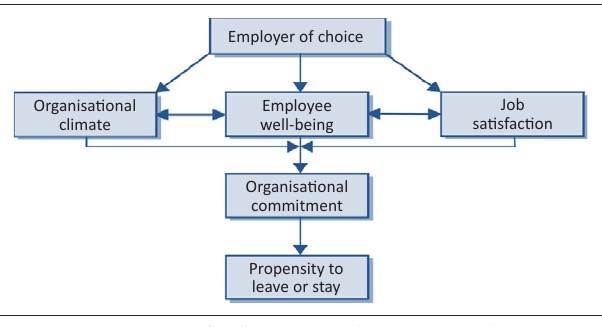
FIGURE 2: Veldman’s employee commitment